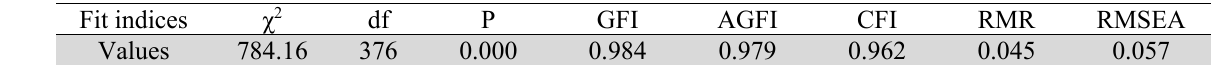
Goodness-of-fit